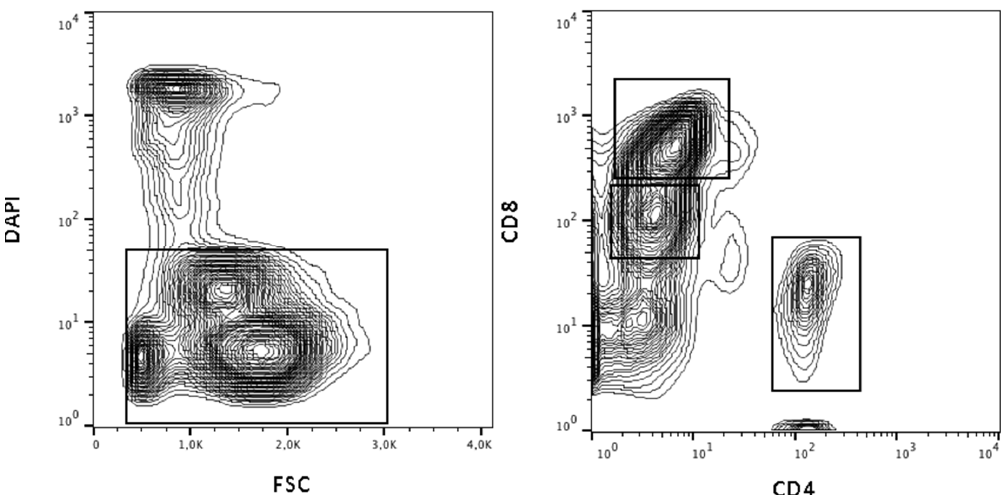
Figure 3. Cell sorting and dead cell exclusion. After dead cell exclusion via DAPI stain, the viable cells were further sorted and analyzed separately for viral infection. Dead cell exclusion is shown in the left plot. Sorting strategy for CD4, CD8-high and CD8-low cells is shown in the right plot. Table 3. EBV-PCR analysis of FACS-sorted cell subsets. Population CD8-High CD4+ CD8-Low CD19+ Granulocytes EBV-PCR negative negative positive positive negative